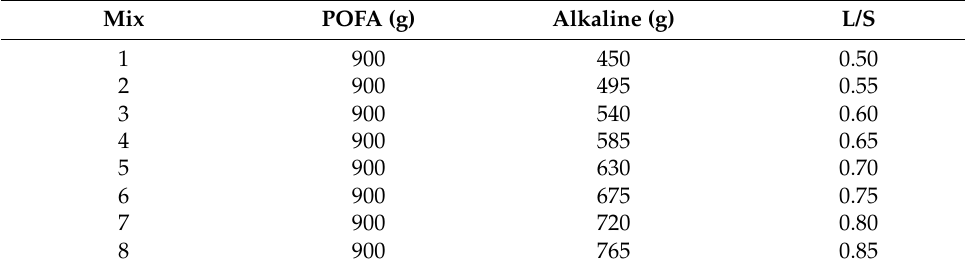
Table 1. Proportions of various L/S in the mixture.